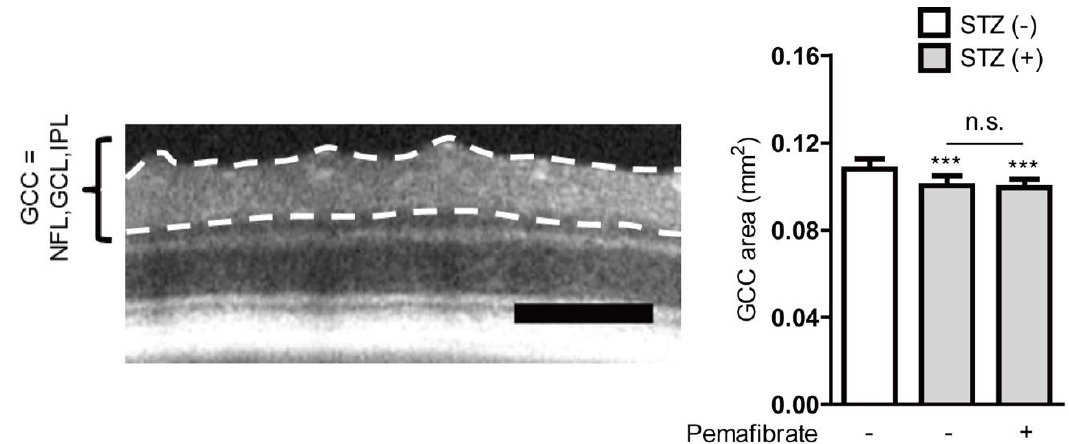
Figure A2. A representative retinal image of the optical coherence tomography (OCT) (left). GCC; ganglion cell complex, NFL; nerve fiber layer, GCL; ganglion cell layer, IPL; inner plexiform layer. Scale bar, 0.2 mm. Comparison of the GCC areas among the naive mice and the STZ-induced diabetic mice with vehicle or pemafibrate administration (right). Quantitative analysis showed that pemafibrate did not rescue the reduced GCC area in STZ-induced diabetic mice ( n = 12–16 per group). p > 0.05, compared with vehicle-administered diabetic mice, *** p < 0.001, compared with naive mice. The graph is presented as mean ± standard deviation. The data were analyzed using one-way ANOVA followed by a Bonferroni post hoc test.